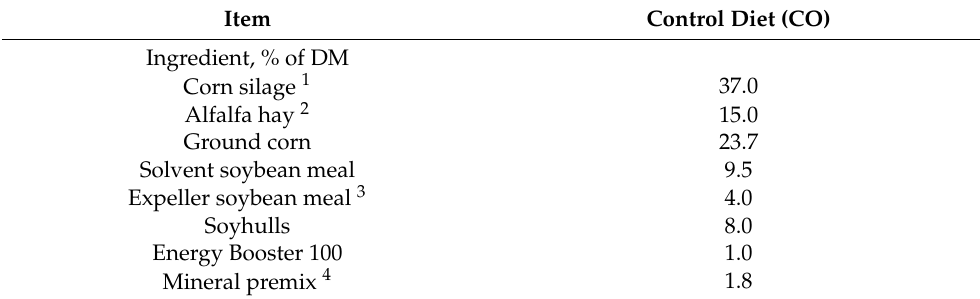
Table 1. Ingredient composition of control